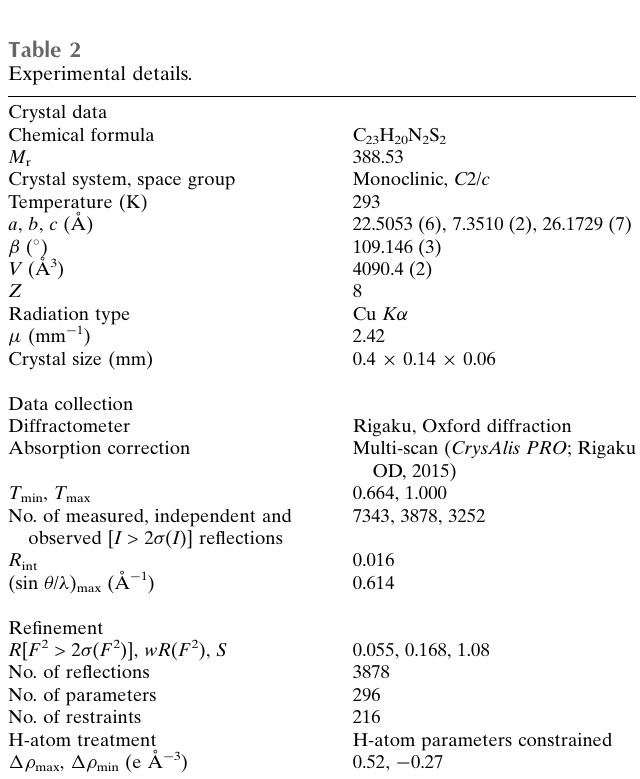
Computer programs: CrysAlis PRO (Rigaku OD, 2015), SHELXT (Sheldrick, 2015 b ), SHELXL (Sheldrick, 2015 a ), OLEX2 (Dolomanov et al. , 2009).